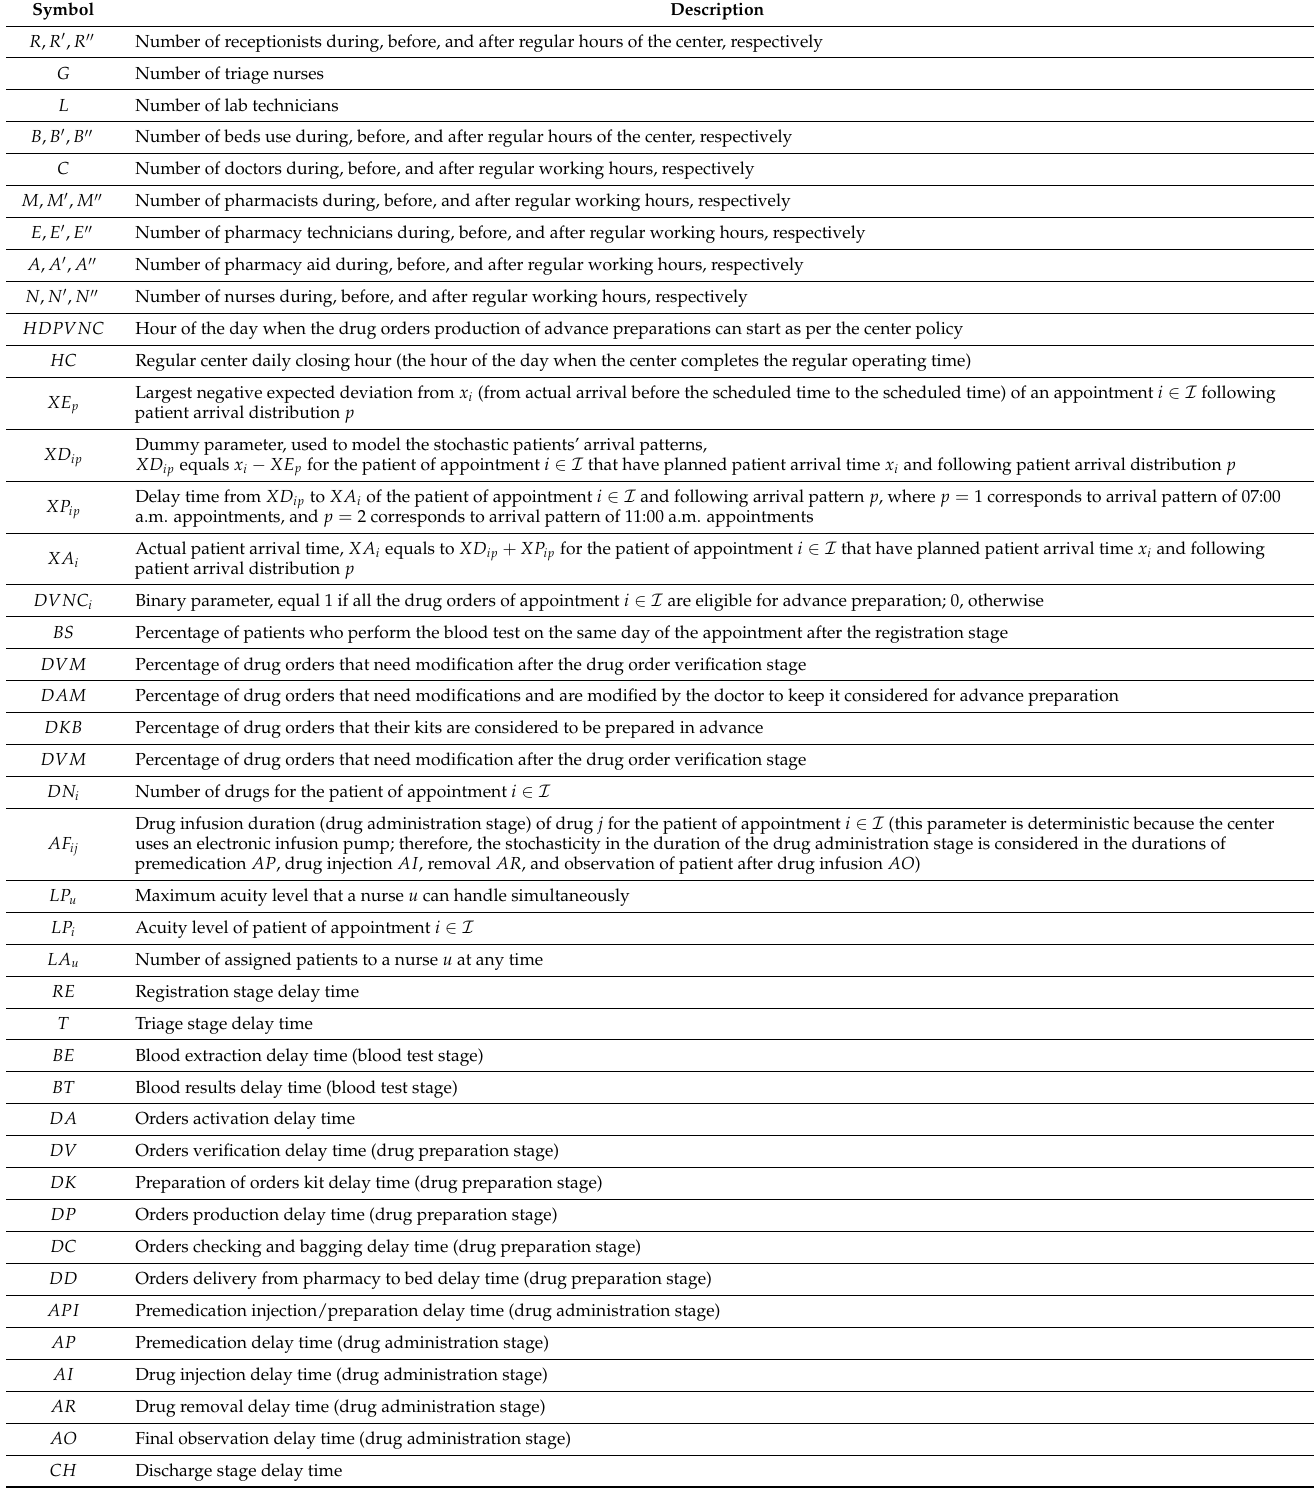
Table A1. Parameters of the stochastic simulation